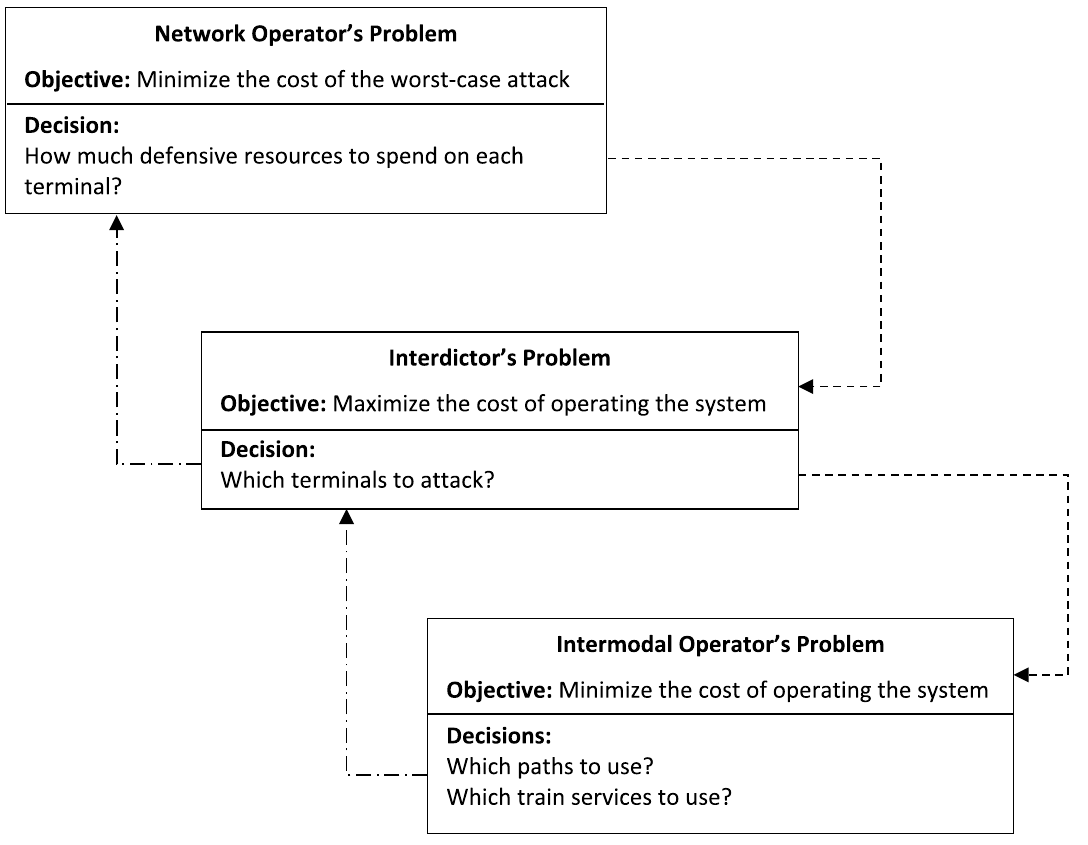
Fig. 1 Hierarchical structure for fortification